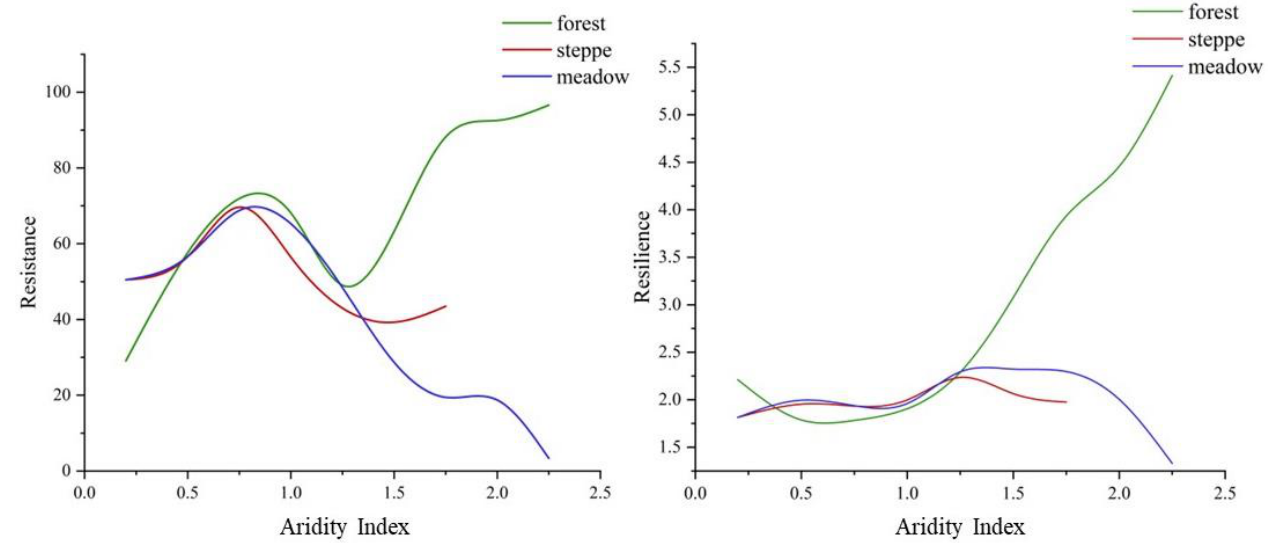
Figure 8. Variation of vegetation stability under different wet and dry conditions on the QTP.